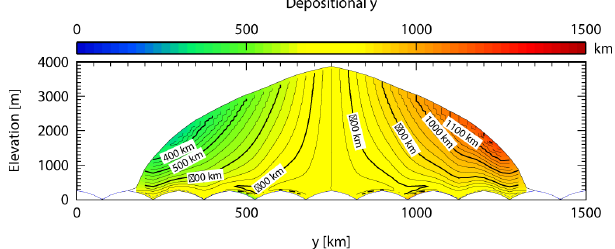
Fig. 10. The cross section of the resulting δ 18 O distribution as calculated in SICOSTRAT. Since the Figure 10. The cross section of the resulting δ 18 O distribution as boundary conditions are time independent, the δ 18 O value is also independent of the ice age and is calculated in SICOSTRAT. Since the boundary conditions are time similar to Fig. 8 because the transport perpendicularto the cross-section is small. independent, the δ 18 O value is also independent of the ice age and is similar to Fig. 8 because the transport perpendicular to the cross section is